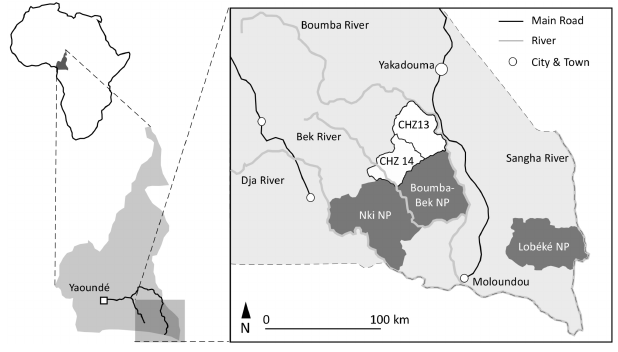
Fig. 1 . Map of southeastern Cameroon showing the three national parks and community hunting zones (CHZs) 13 and 14. In addition to the main roads shown, there are many secondary roads, most of which are constructed and maintained by logging companies. NP indicates national